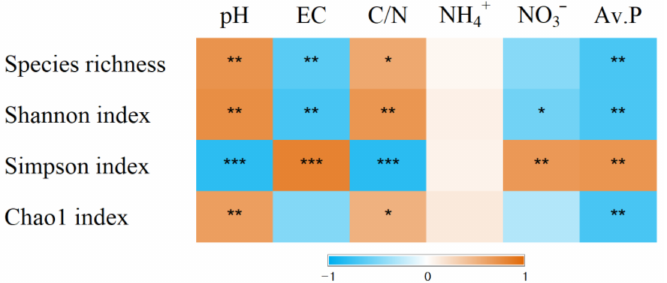
Figure 2. Spearman’s correlation coefficient between diversity indices and soil chemical properties ( n = 15). The colour indicates the value of correlation coefficient ( − 1 < r < 1). *, **, and *** indicate significant correlation at p < 0.05, p < 0.01, p <